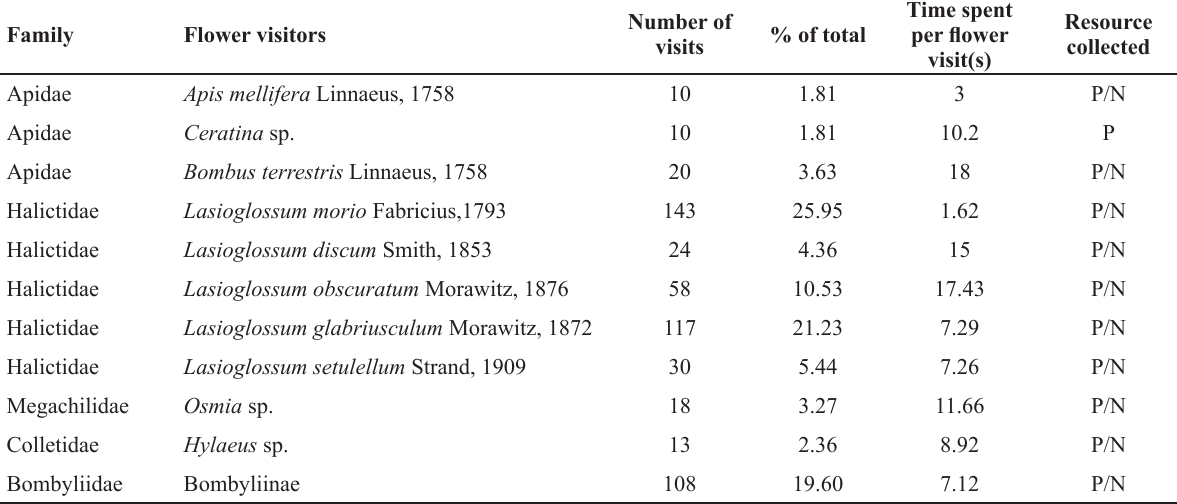
Table 4 – Flower visitors of Campanula vardariana , the number of visits recorded, the percentage of the total number of visits, the duration